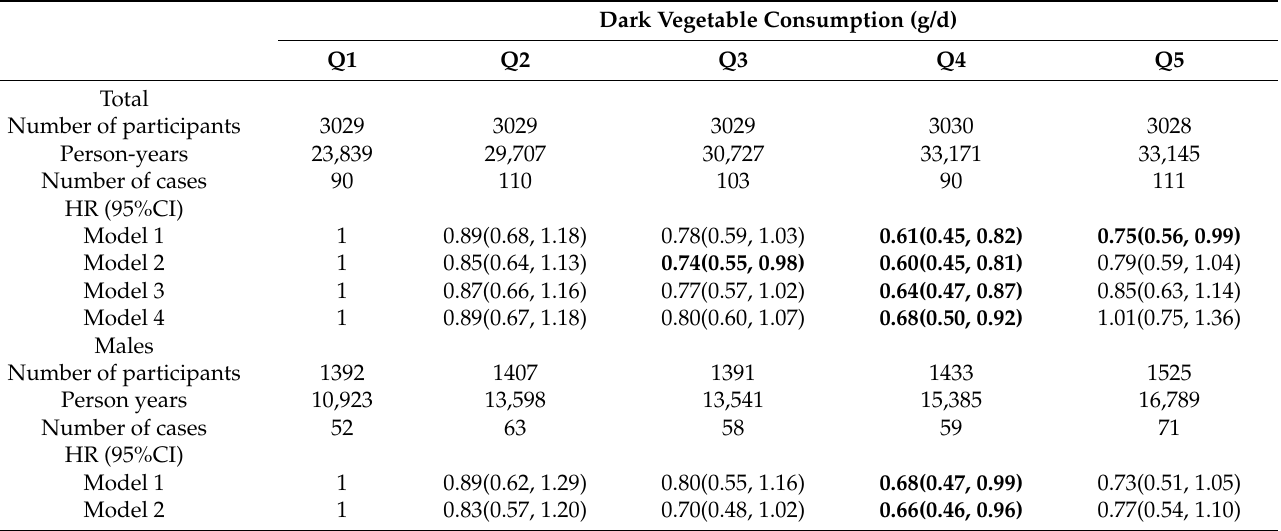
Table 3. Multivariate adjusted hazard ratios (HR) for stroke, according to dark vegetable consumption (CHNS study,